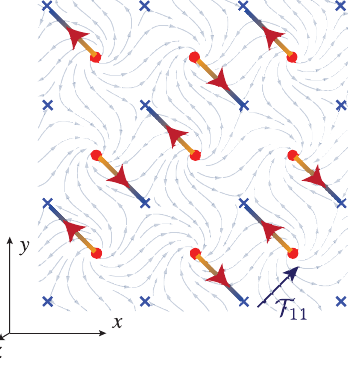
FIG. 14. Surface chiral Dirac channels of the coupled-wire model (2.12) terminated along the xy